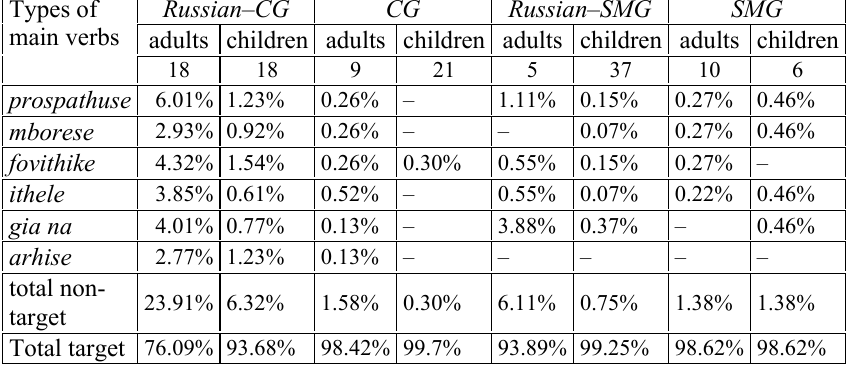
Table 8: Non-target production in the oral video stimuli task